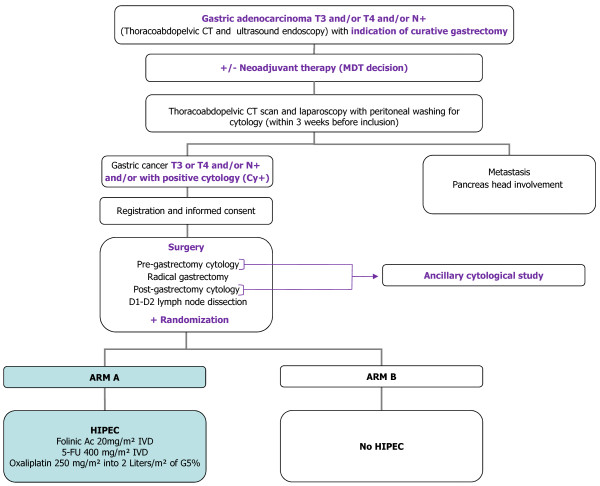
GASTRICHIP study flow-chart.